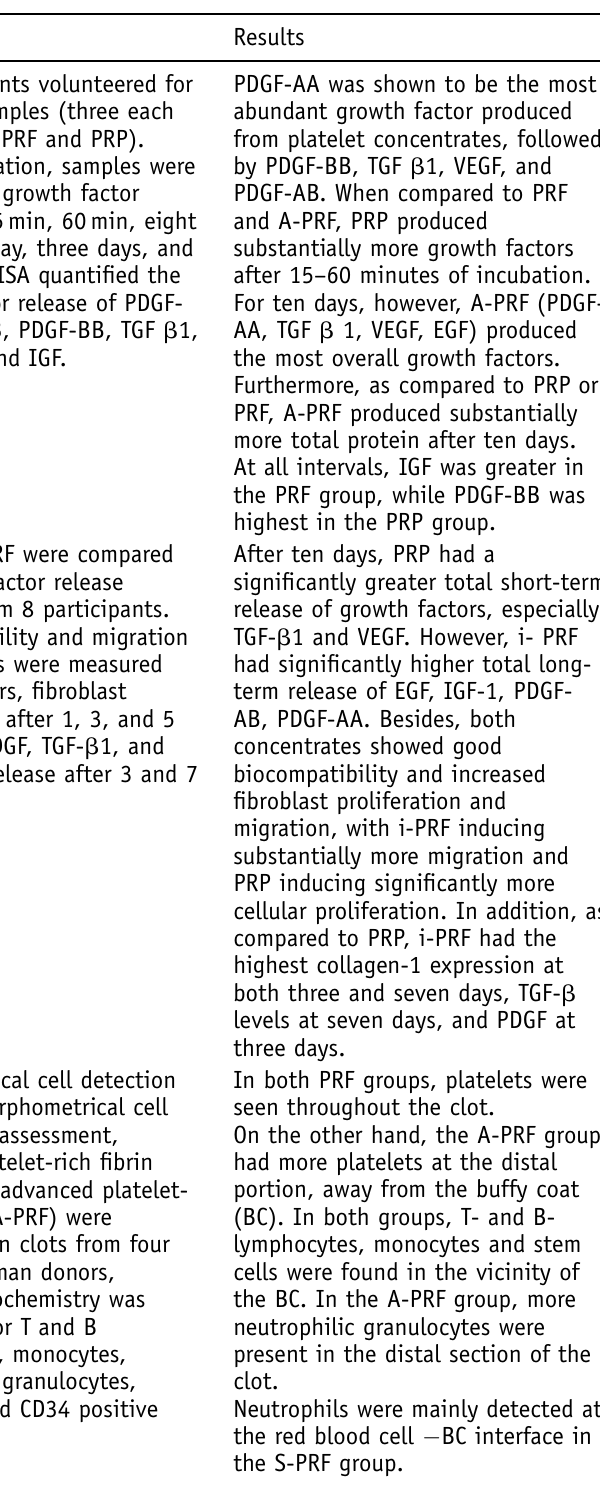
Table III. Growth factors and platelet